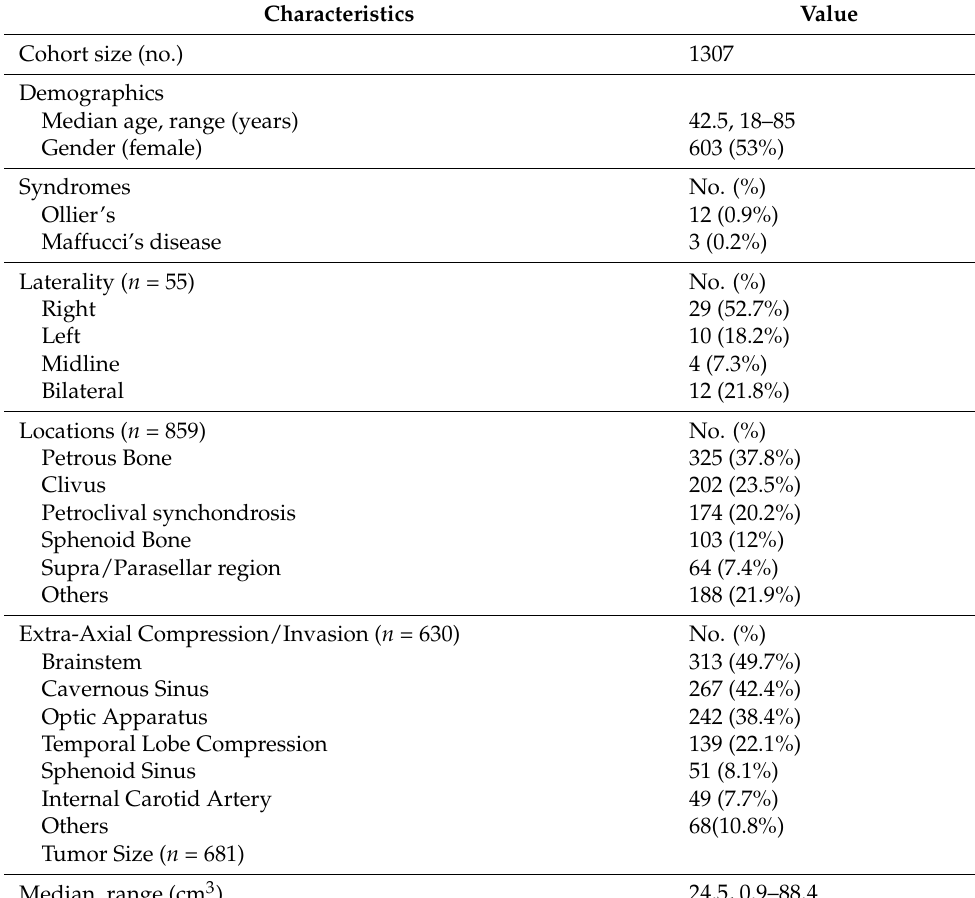
Table 1. Summary of demographics and anatomical features of all pooled